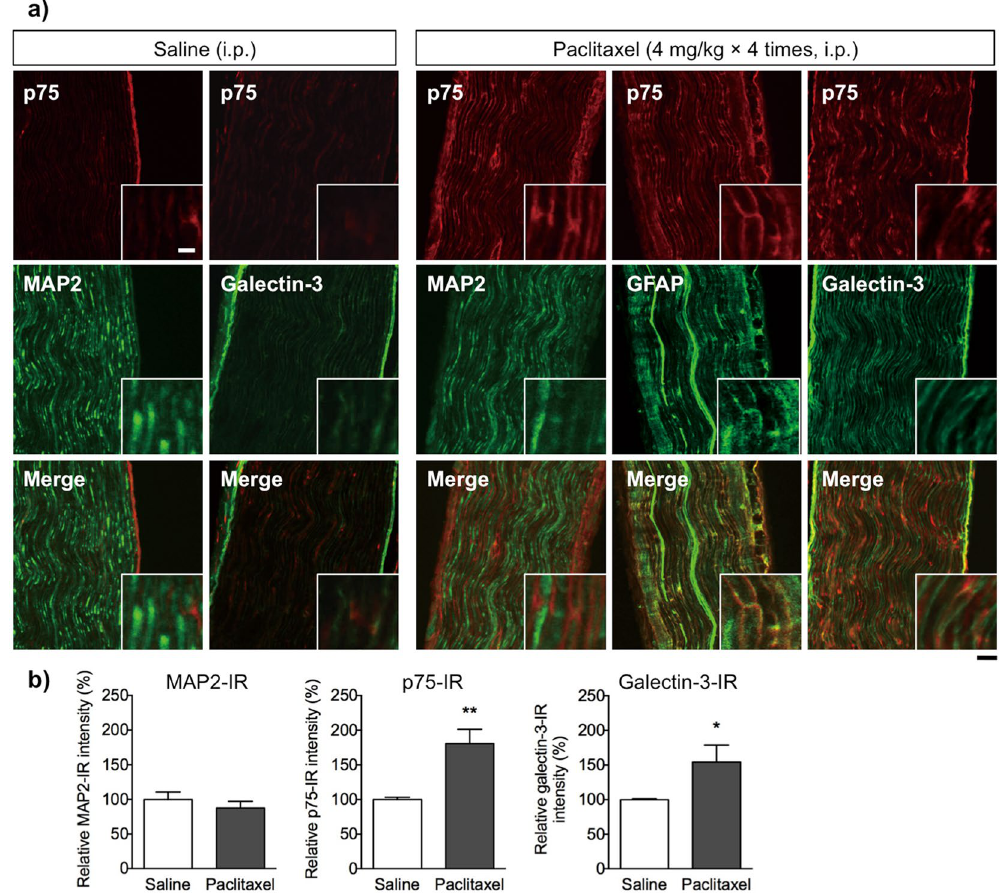
Figure 8. Changes in the expression of p75 and galectin-3 in sciatic nerves isolated from mice treated with paclitaxel. Paclitaxel (4 mg/kg) was injected intraperitoneally on Days 0, 3, 5, and 7. At 1 day after the last injection, mice were fixed and subjected to immunohistochemical assay. ( a ) Longitudinal sections of sciatic nerve isolated from saline- or paclitaxel-treated mice were co-immunolabeled for p75 (red), or MAP2, GFAP or galectin-3 (green). Scale bar: 50 μ m (10 μ m in enlarged images). Repeated injection of paclitaxel increased p75-IR in GFAP- or galectin-3-positive Schwann cells surrounding MAP2-positive neural axons. ( b ) Quantification of the intensity of fluorescence associated with MAP2, p75 or galectin-3. Each column represents the mean ± S.E.M. n = 3–5. * p < 0.05 and ** p < 0.01 vs . the vehicle-treated